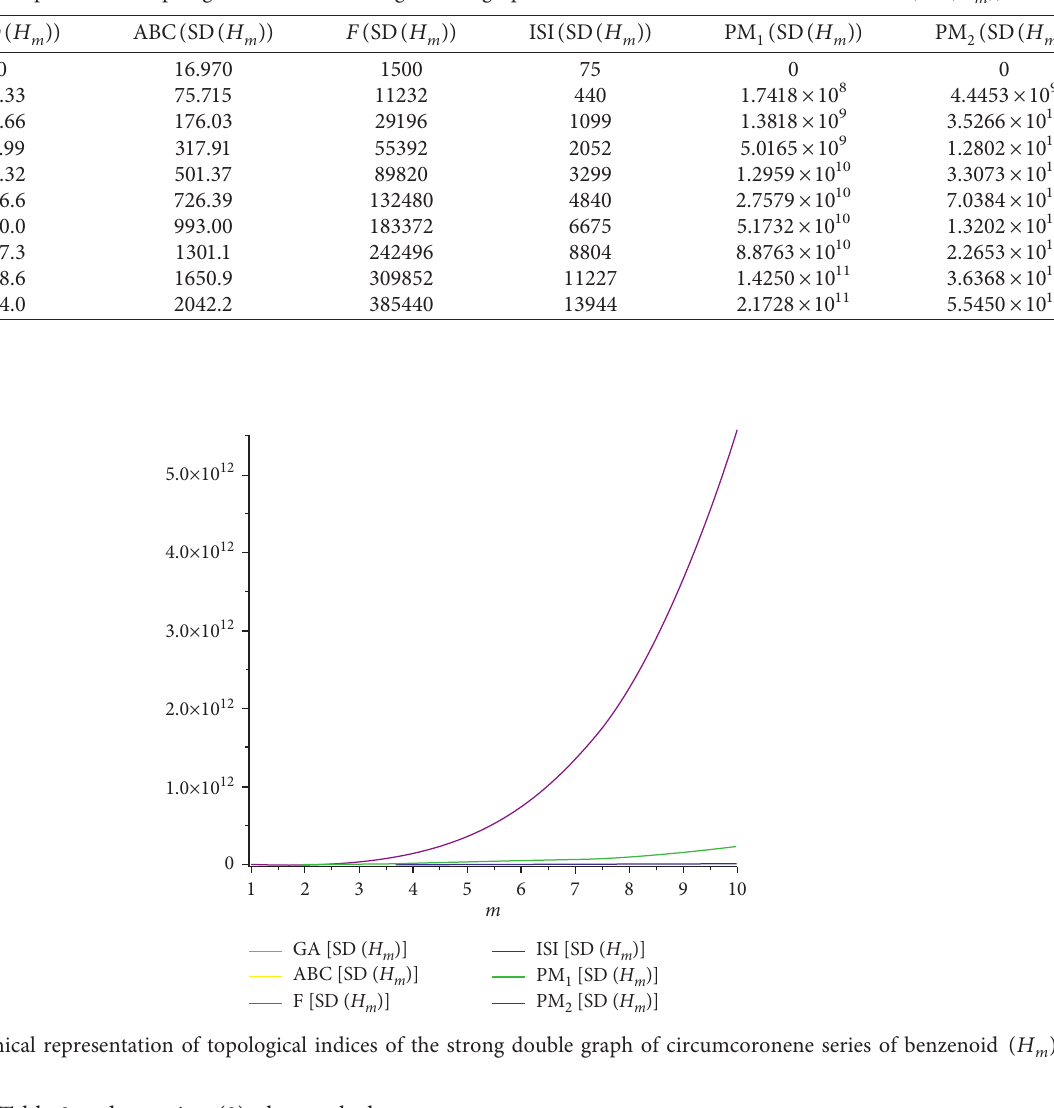
Table 4: Computation of topological indices of strong double graph of circumcoronene series of benzenoid ( SD ( H